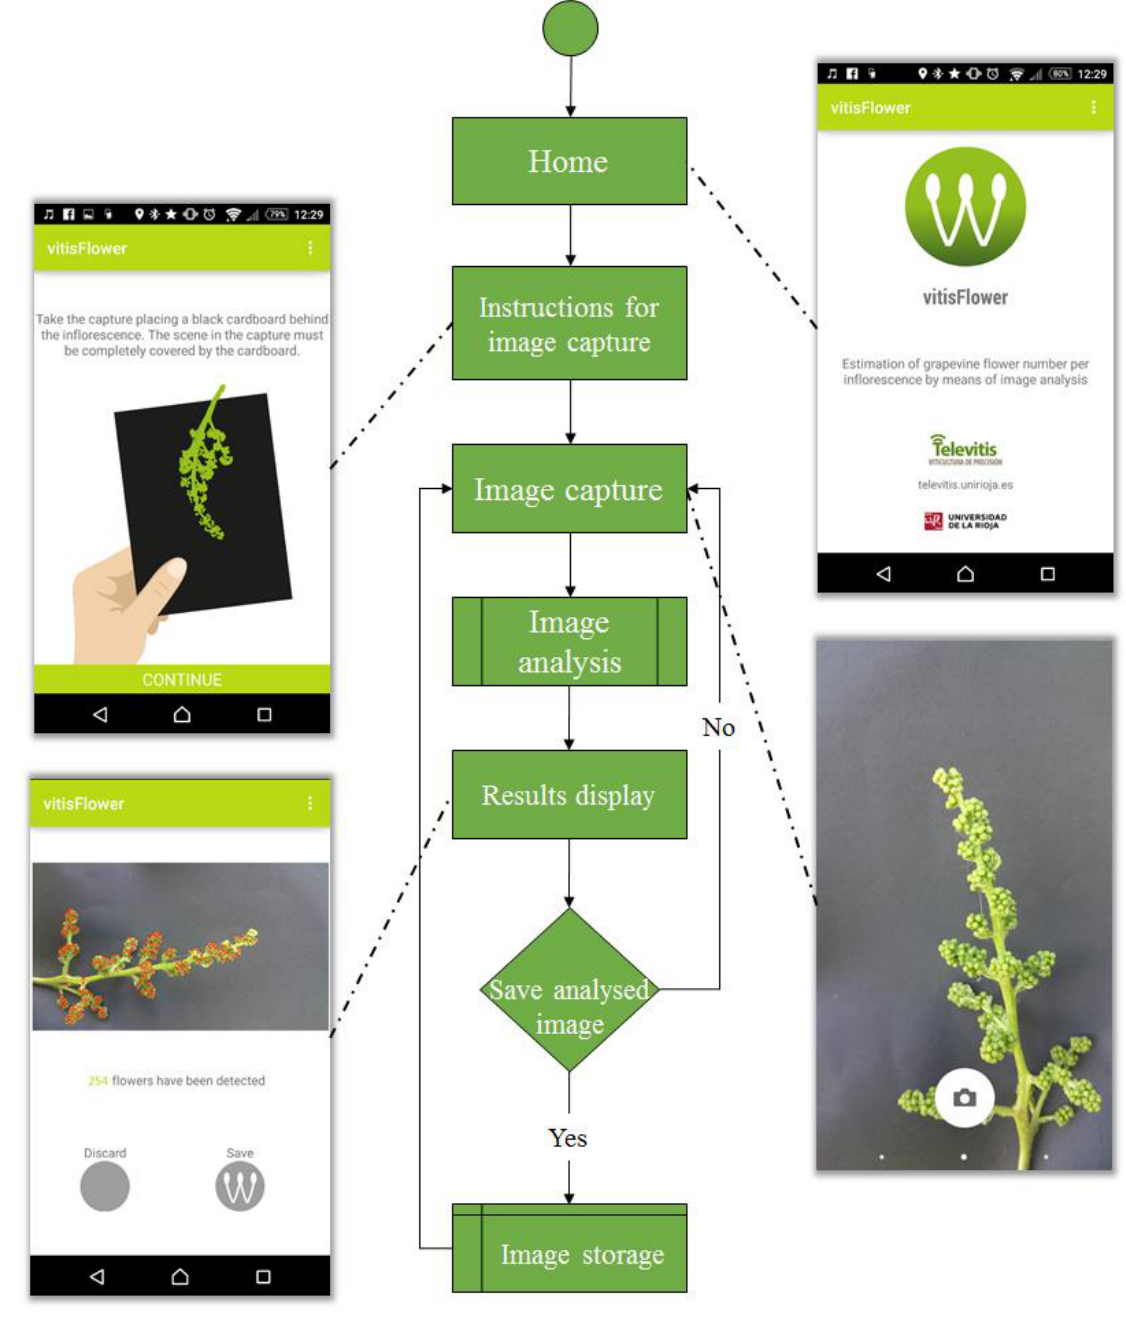
Figure 3. Flow-chart diagram of the vitisFlower ® application illustrated with the application’s